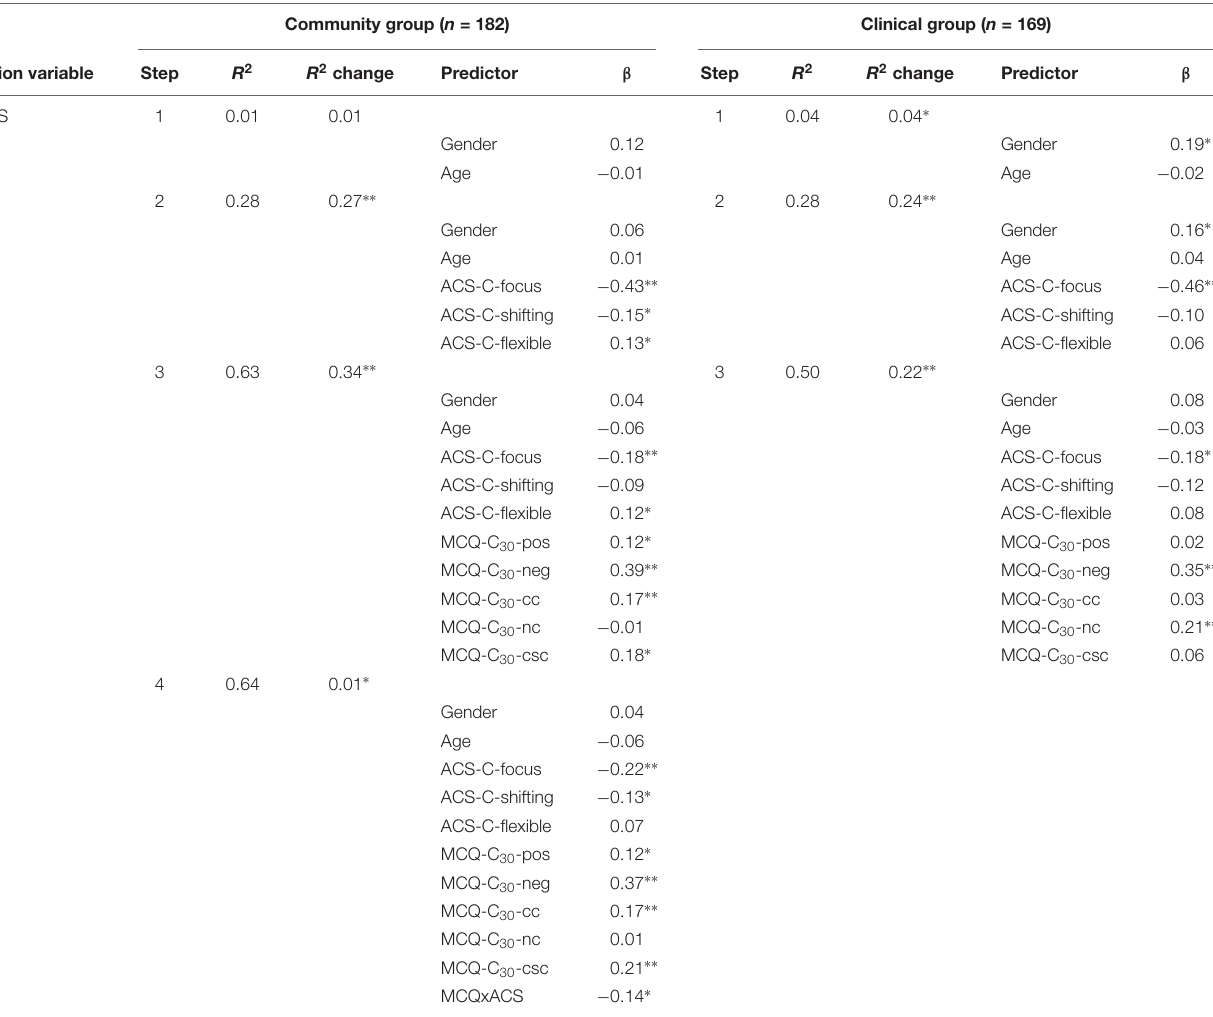
TABLE 3 | Hierarchical regression analysis in the community- and clinical group separately, with RCADS total score as the dependent, gender/age and subscales from the ACS-C and MCQ-C 30 as predictors. Community group ( n = 182) Clinical group ( n =